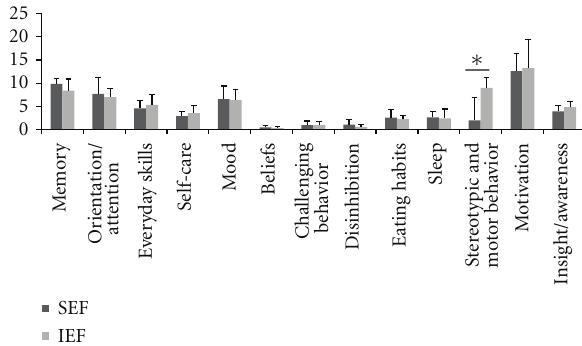
Figure 1: Mean (SD) frequency subtotal for the thirteen domains assessed by the Cambridge Behavioral Inventory. A significant di ff erence was observed only for stereotypic and motor behavior ( ∗ P < .